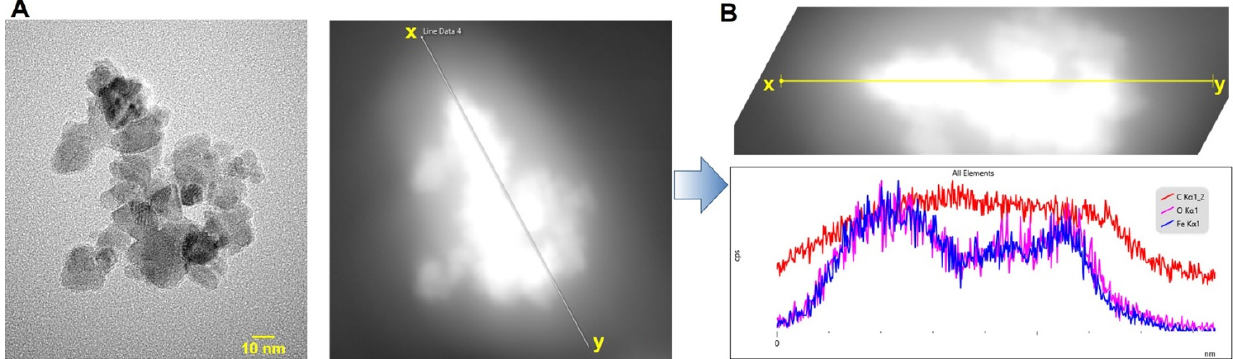
Figure 2. HR-TEM and EDS analysis of PEG–starch–IONPs. ( A ) High-resolution TEM image and ( B ) EDS scan spectrum of the line xy in the ( A ) HR-TEM image.